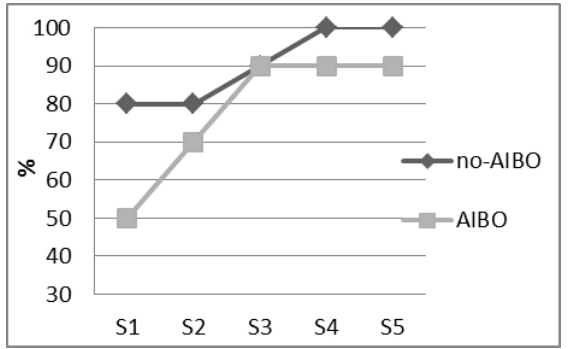
Figure 9. Story ‘sense’ (percentage of meaningful stories) for both modes through sessions 1 to 5. Prolonged interactions with the system in- crease the story believability.